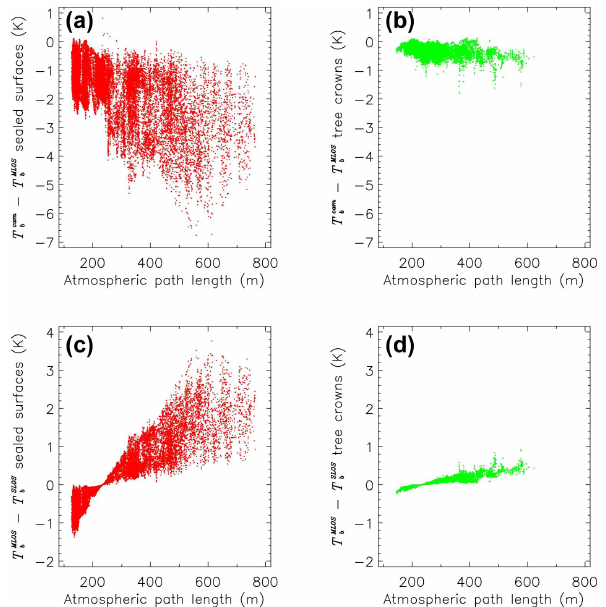
Fig. 10. Relation between atmospheric path length and T cam T MLOS at 12:00 for (a) sealed surfaces and (b) tree crowns. Rela- b tion between atmospheric path length and T MLOS for (c) sealed surfaces and (d) tree